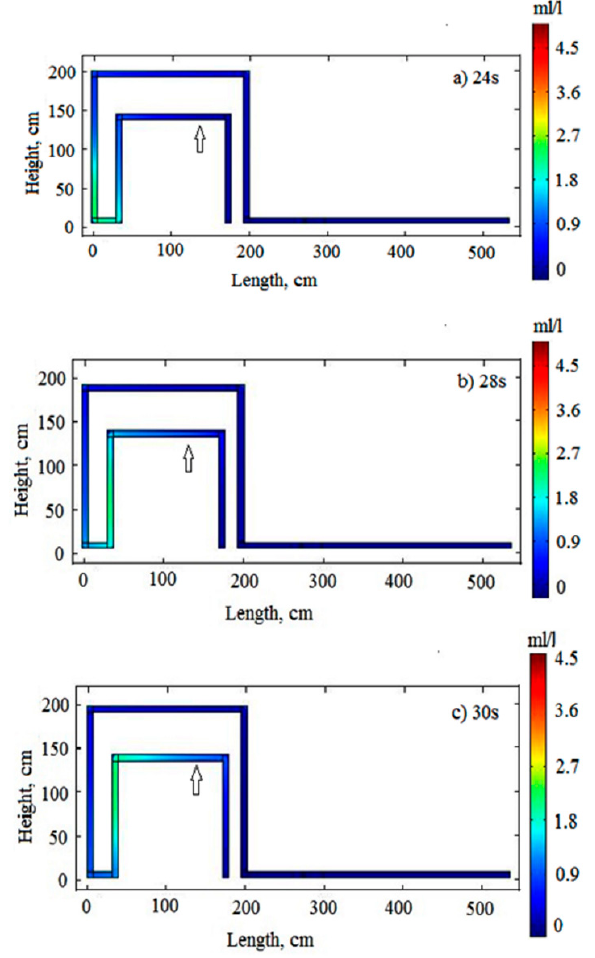
Figure 8. CFD simulation of contaminant evolution at point 3 (50, 143) at 24, 28, and 30 s; initial concentration 40 mL/L; pressure = 2-bar.